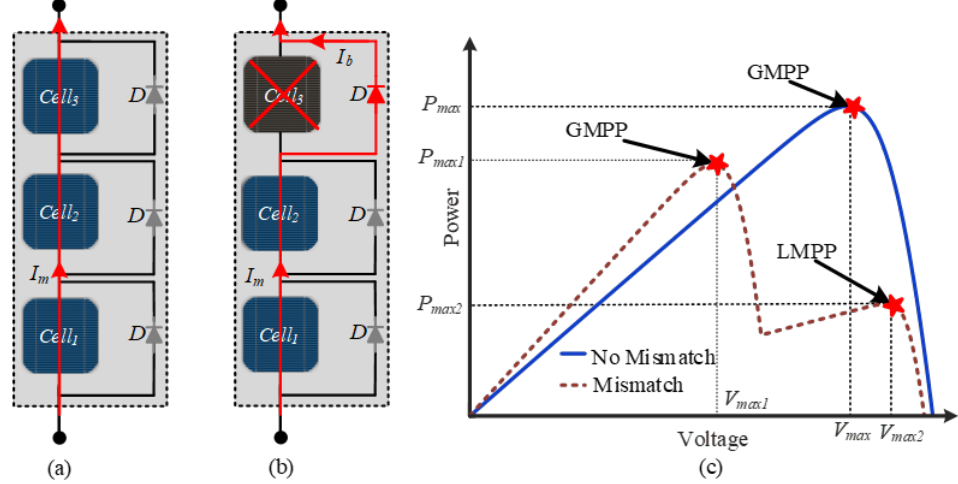
Figure 1. Global estimated energy share of renewable sources from 2019 [1].